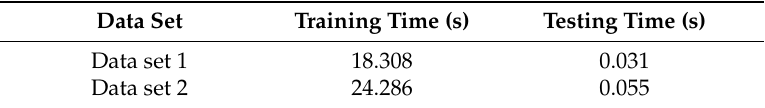
Table 3. The computational time of the lasso models for data sets 1 and 2.